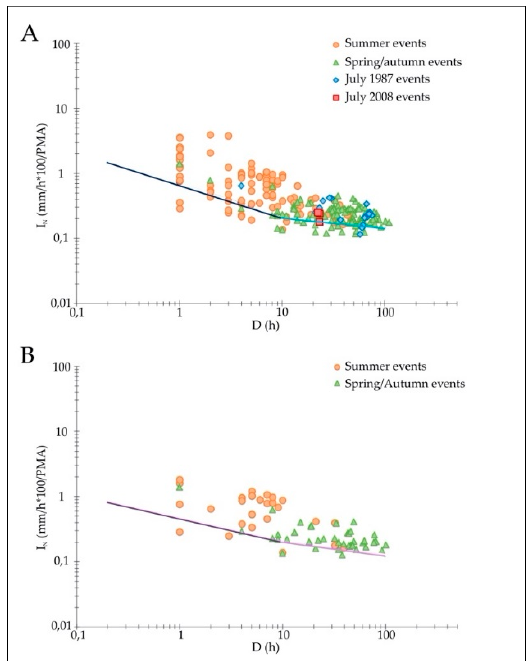
Figure 11. Rainfall events (coloured marks) that have resulted in soil slips and mud-debris flows in the Central -and South-Eastern Alps sector of the Lombardy Region in the period 1927–2008. Coloured lines represent threshold that leave 90% empirical points I N D above the curve for different range of duration (dark red, D < 10 h; light red, D > 10 h).